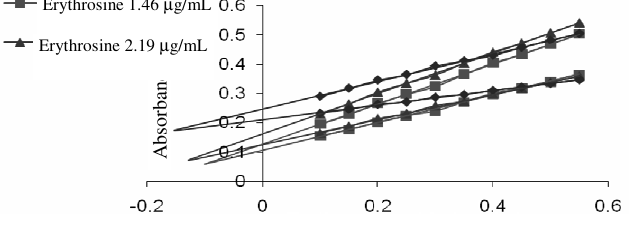
Figure 8. Plot of H -point standard addition method for simultaneous determination of fixed amounts of eosin concentration (1.24 µ g/mL) and different amounts of erythrosine, when different standard erythrosine solutions are added Accuracy and